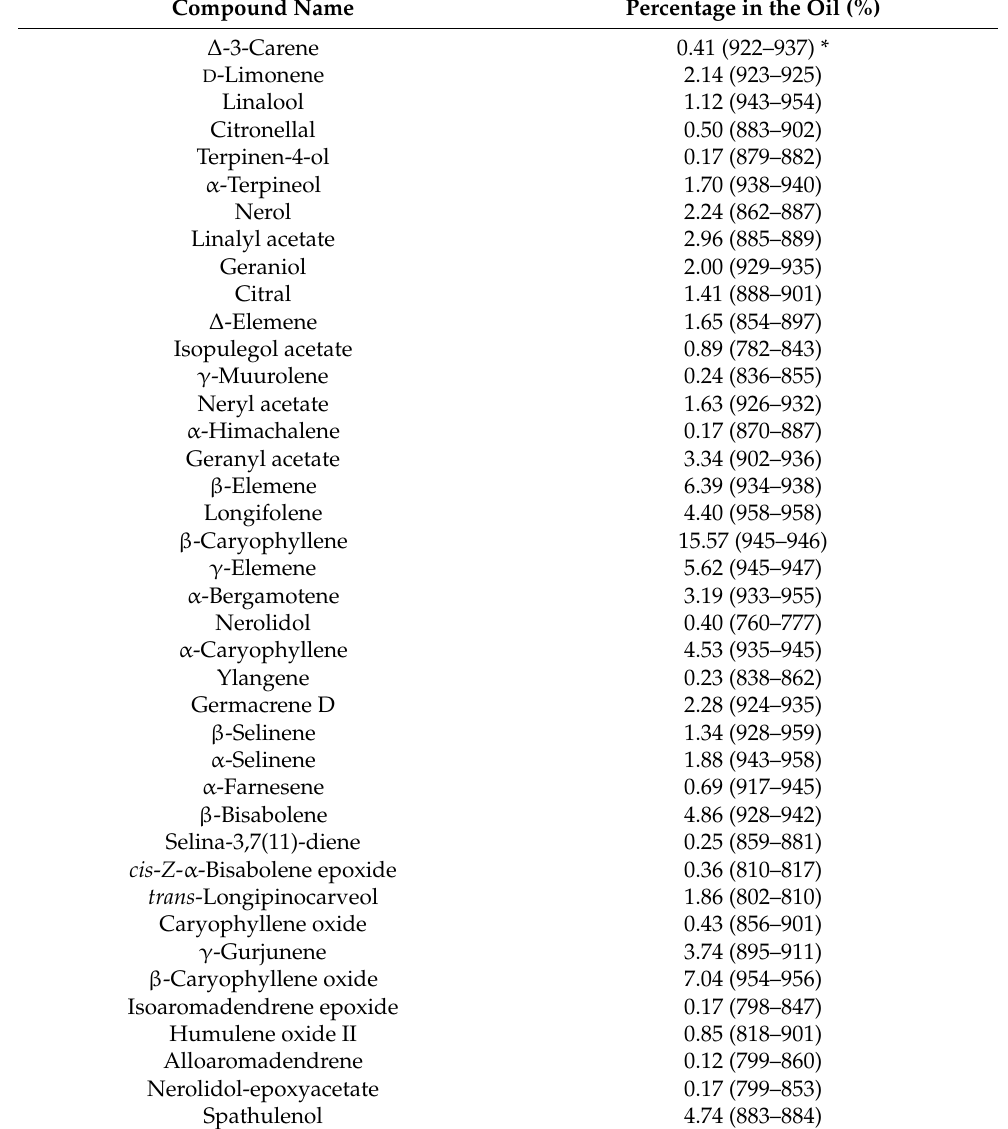
Table 2. Chemical composition of the essential oil from Citrus reticulata